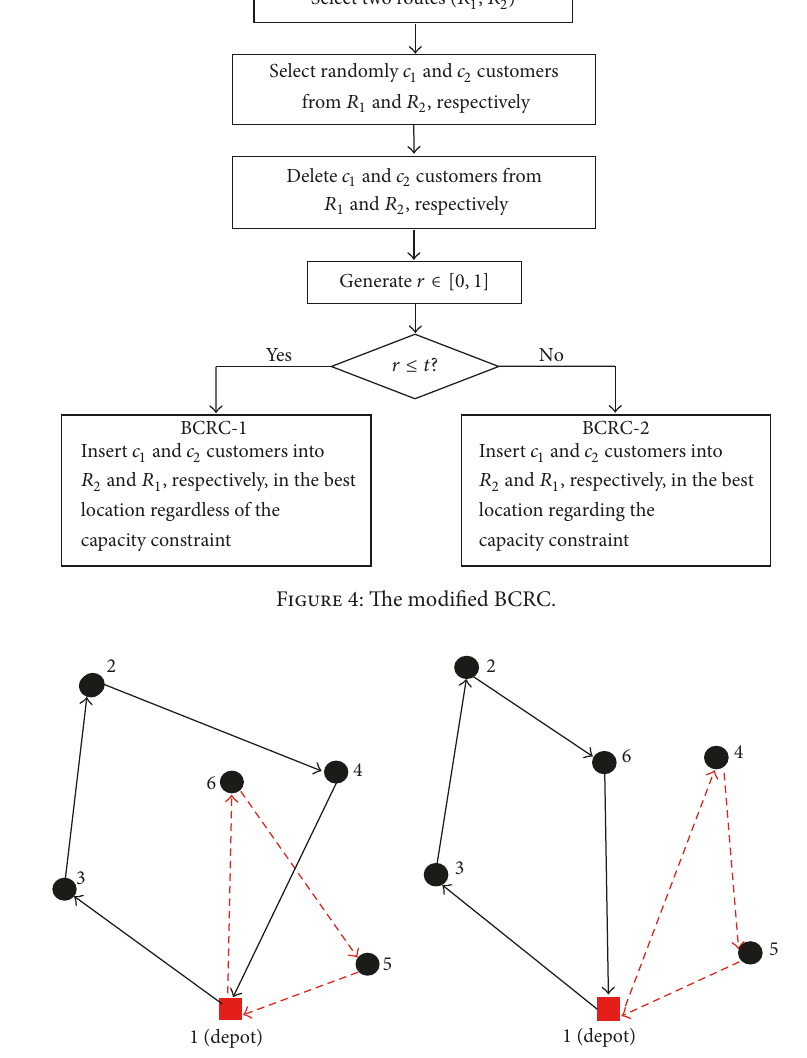
Figure 5: The example of crossover